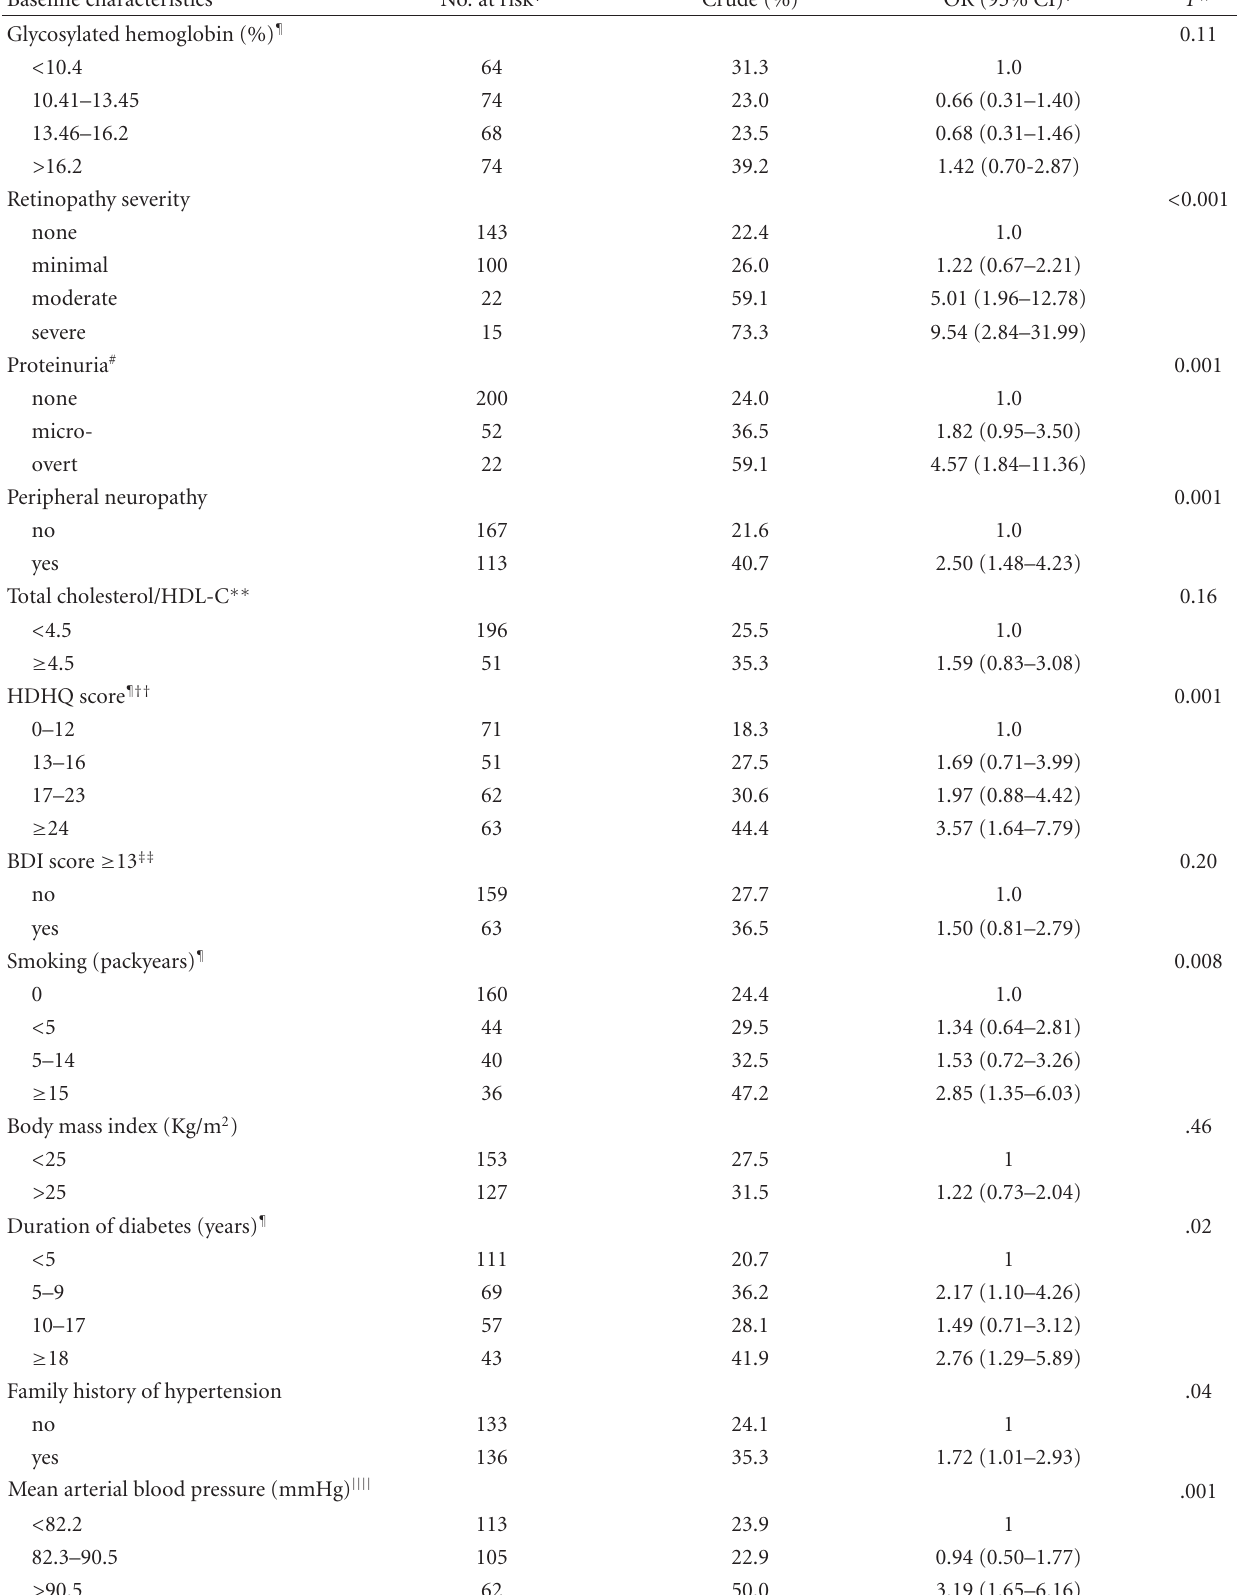
Table 2: Six-year incidence of hypertension ∗ by baseline characteristics: bivariate